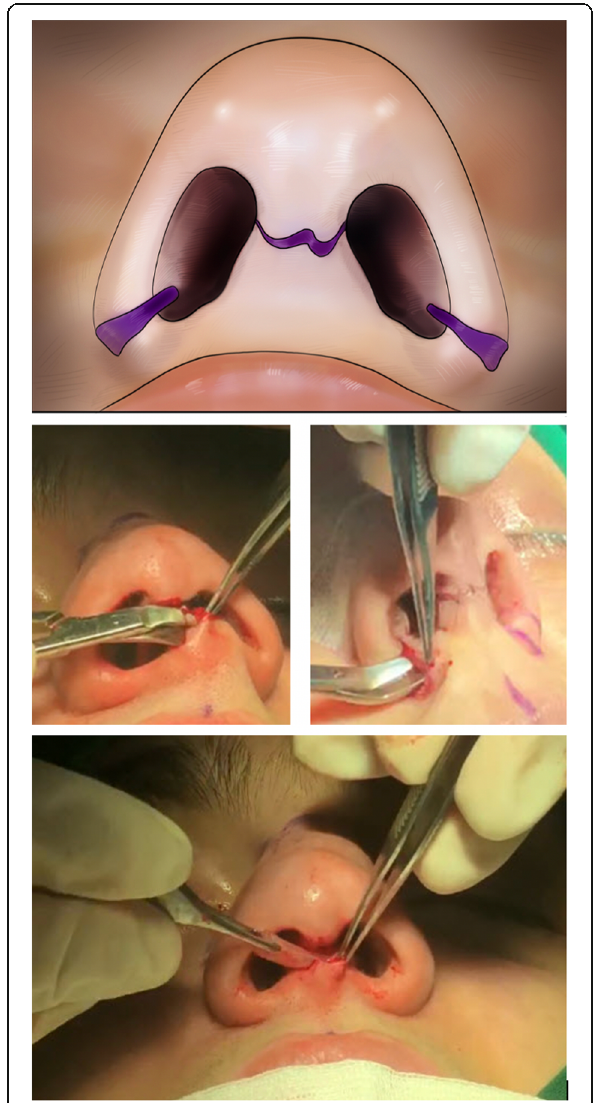
Fig. 1 a Approaches to access the sill area. b Access to the sill area through the incision made in the lower third of the columella in the open rhinoplasty approach. c Access to the sill area from the incision at the nostril base in a patient who underwent alar base reduction. d Hemostasis is achieved, and an adequately shaped cartilage graft harvested from the septal cartilage or the conchal cartilage is inserted into the tissue pocket. Septal cartilage is considered as the most common source for the harvesting of cartilage graft in rhinoplastic